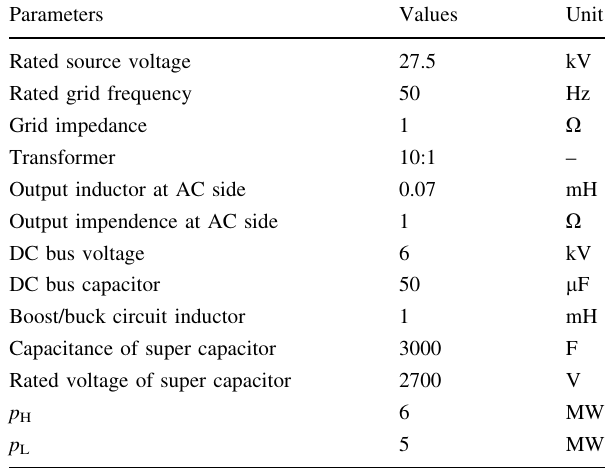
Table 1 Simulation parameters Parameters